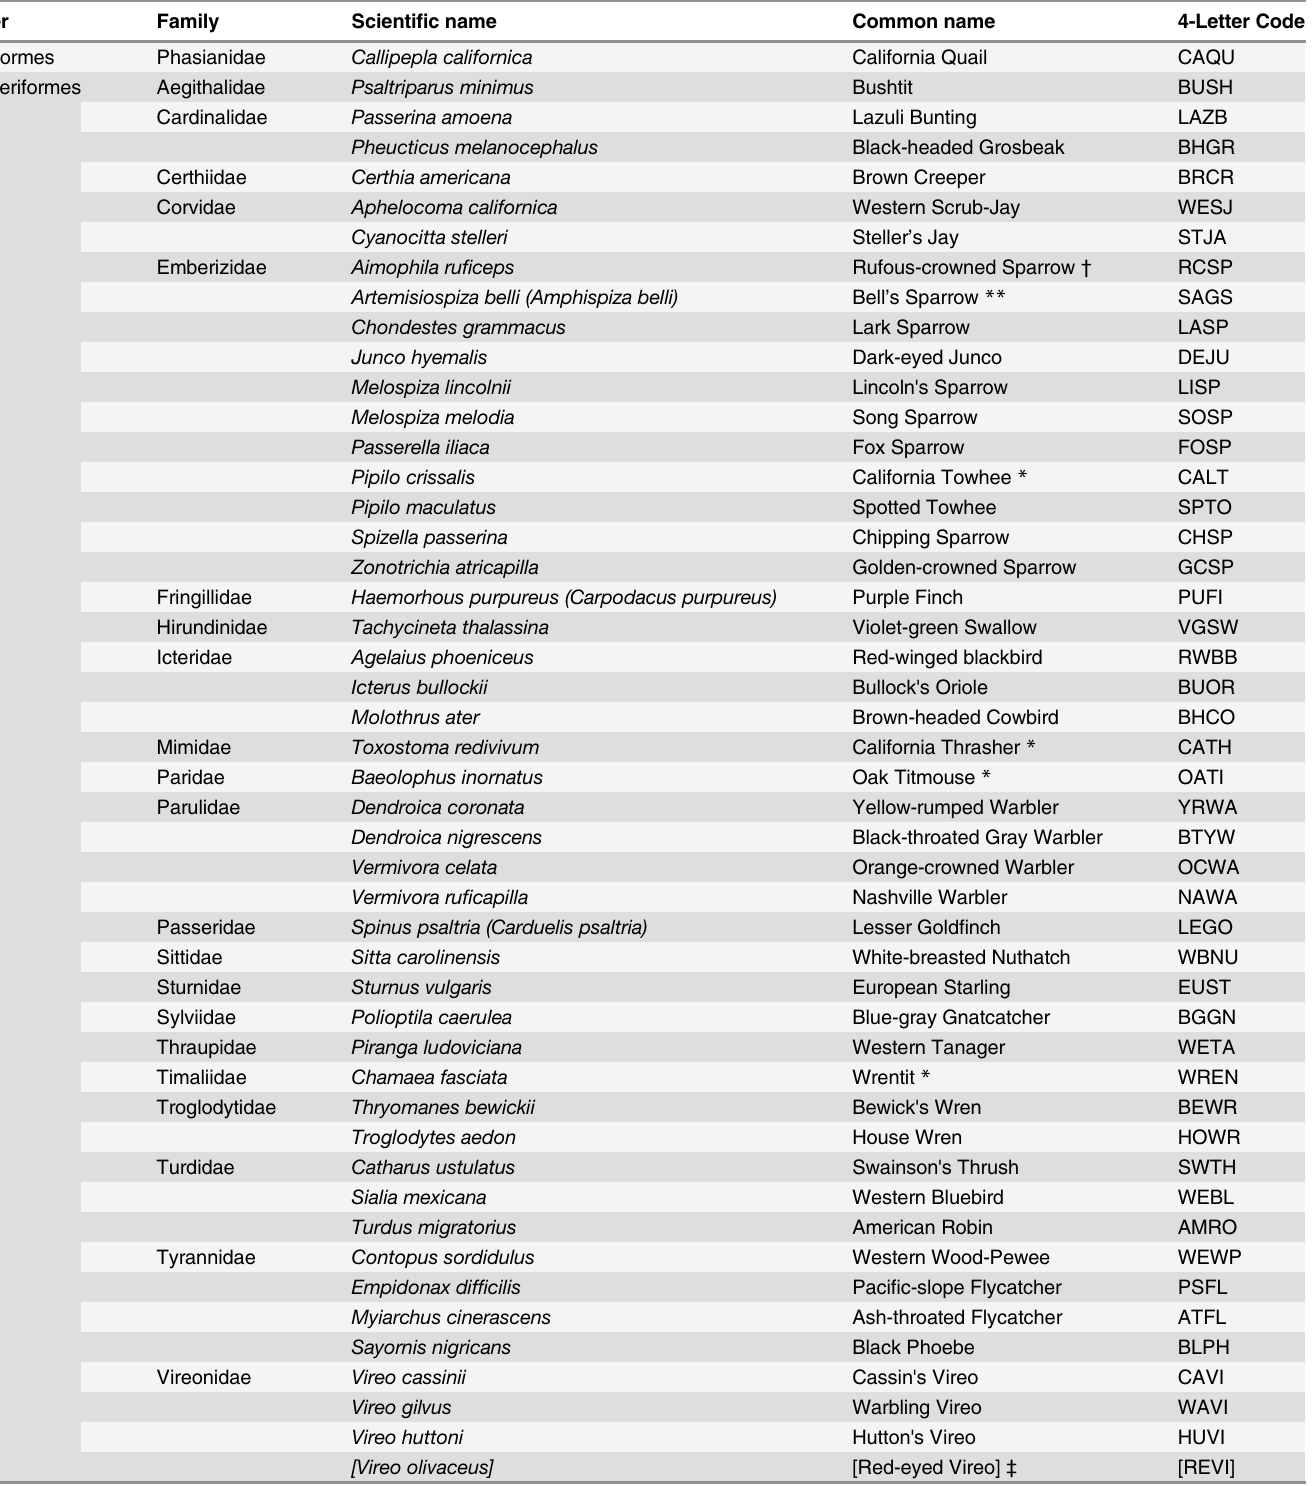
Table 1. Bird taxonomic hierarchy and 4-letter codes for species identi fi